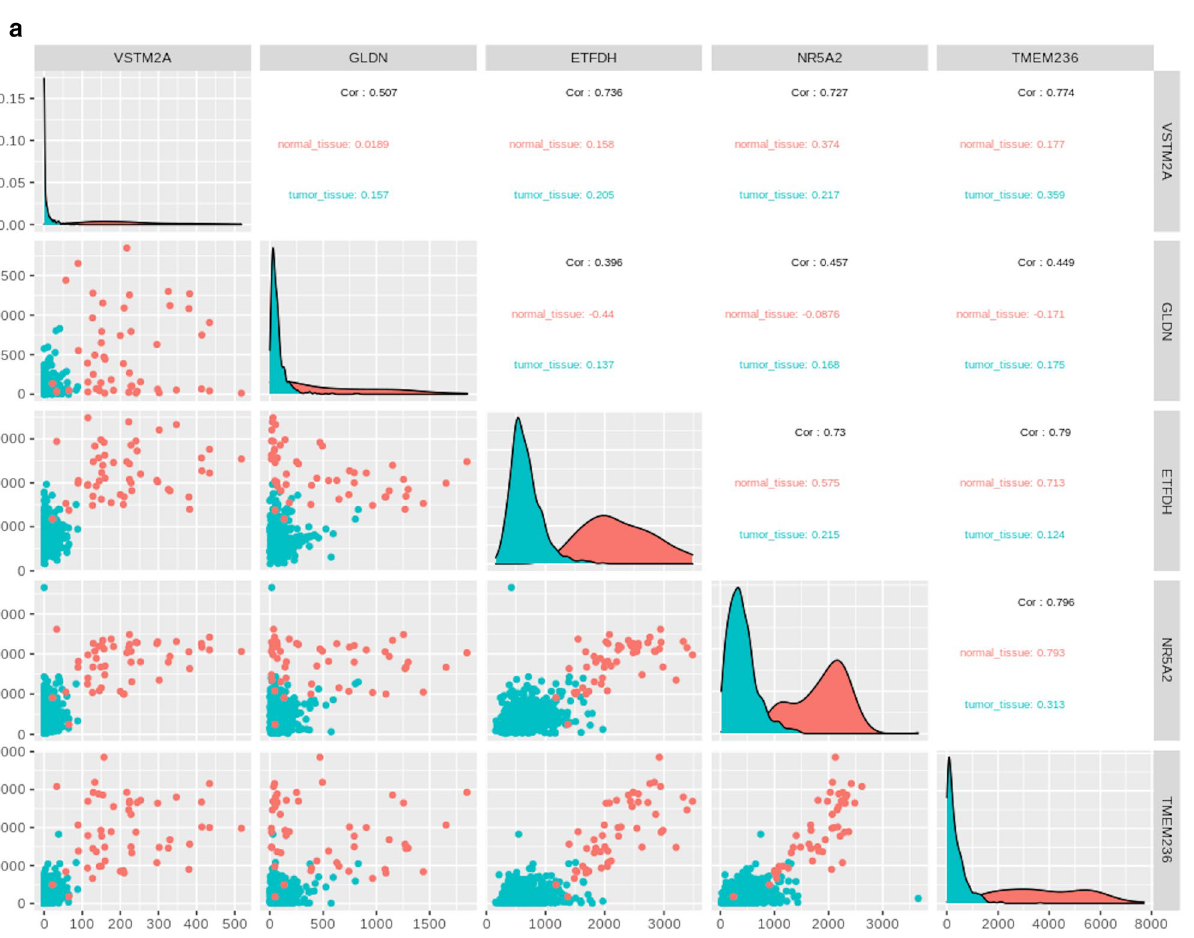
Figure 8. Correlation analysis and location of significant genes. ( a ) Correlation plot between final selected genes (VSTM2A, GLDN, ETFDH, NR5A2, and TMEM236), ( b ) Circos plot to show the genomic location of the selected genes where the outermost band shows the karyotype and the circle inside that shows the total DEGs obtained through traditional approach while the circle inside that with pink background shows the final selected 38 common genes between ML and traditional DEG approach. Red color: Normal tissue samples, and Blue color: CRC tumor tissue samples, and ( c ) gene interaction pathway for TMEM236